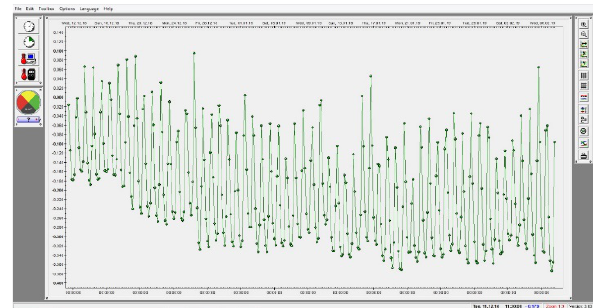
Figure 9. Digital crack monitor results showing the daily movement of 0,061+mm and 0,042- mm due to thermal expansion